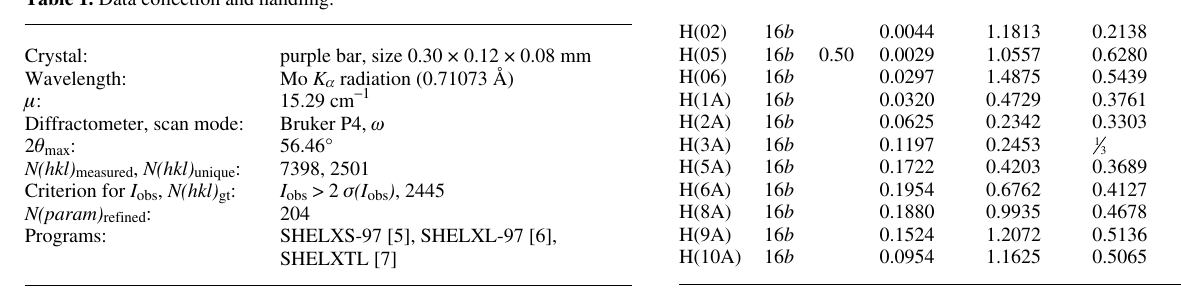
Table 2. Atomic coordinates and displacement parameters (in Å 2 ) . Atom Site Occ.